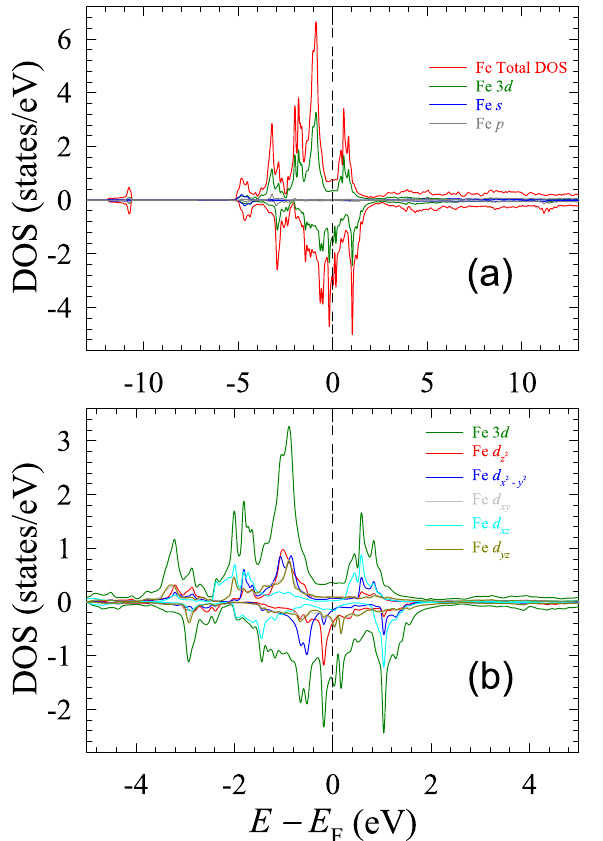
Figure 4. Spin-resolved, Fe total and orbital-resolved DOS ( a ) and Fe d -orbital-resolved DOS ( b ). SigmaPlot v14, www. systa tsoft ware. com.